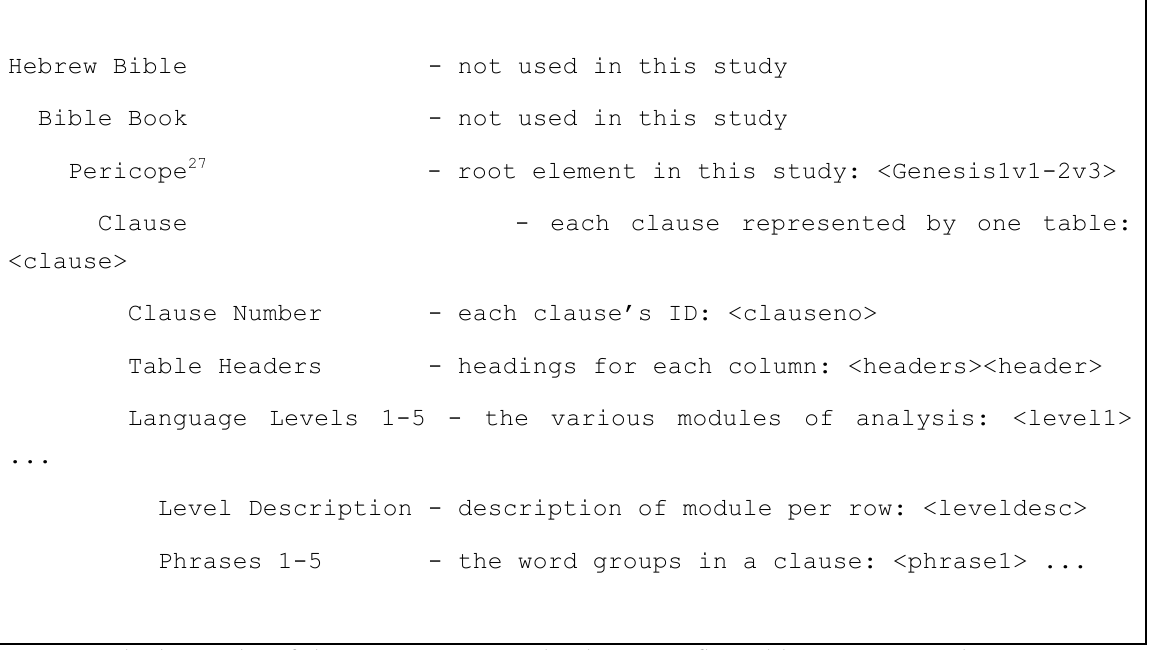
- headings for each column: <headers><header> Language Levels 1-5 - the various modules of analysis: <level1>